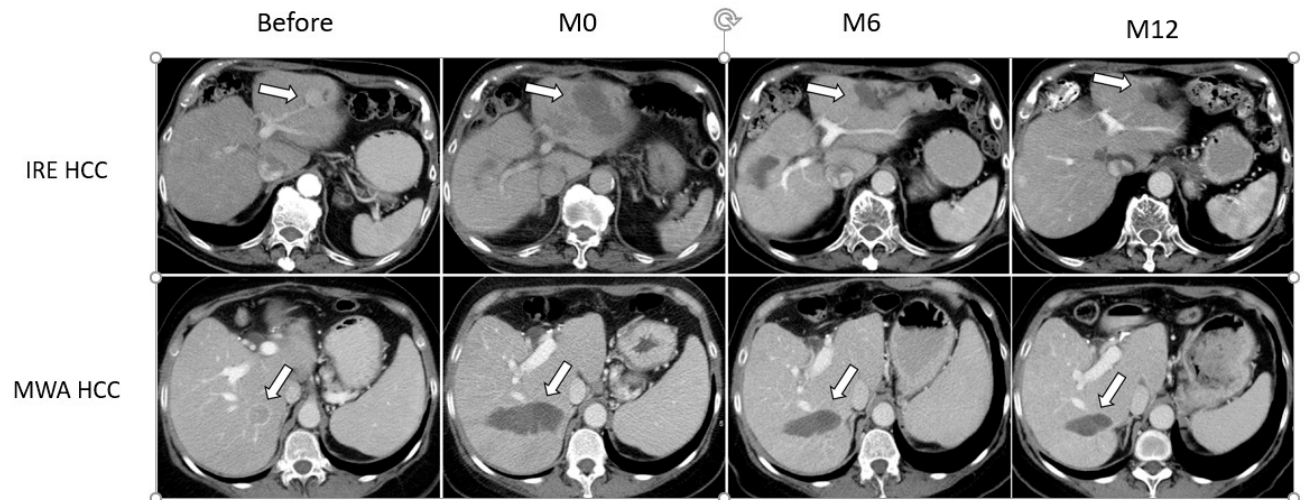
Figure 2. Example of ablation zone involution for HCC. Axial CT slices showing 2 HCC lesions (white arrow) in two different patients: one in left hemiliver (upper row) that was treated with IRE, and one in segments 6/7 (lower row) treated with MWA. Lesions are shown before ablation, immediately after (M0), and at 6 (M6) and 12 months (M12) follow-up. Although a perceptible difference with smaller ablation surface area is seen in patient treated with IRE, the difference between IRE and MWA did not reach statistical significance (Interaction p = 0.17). Table 3. Effect of treatment on surface area at each time point by disease type.